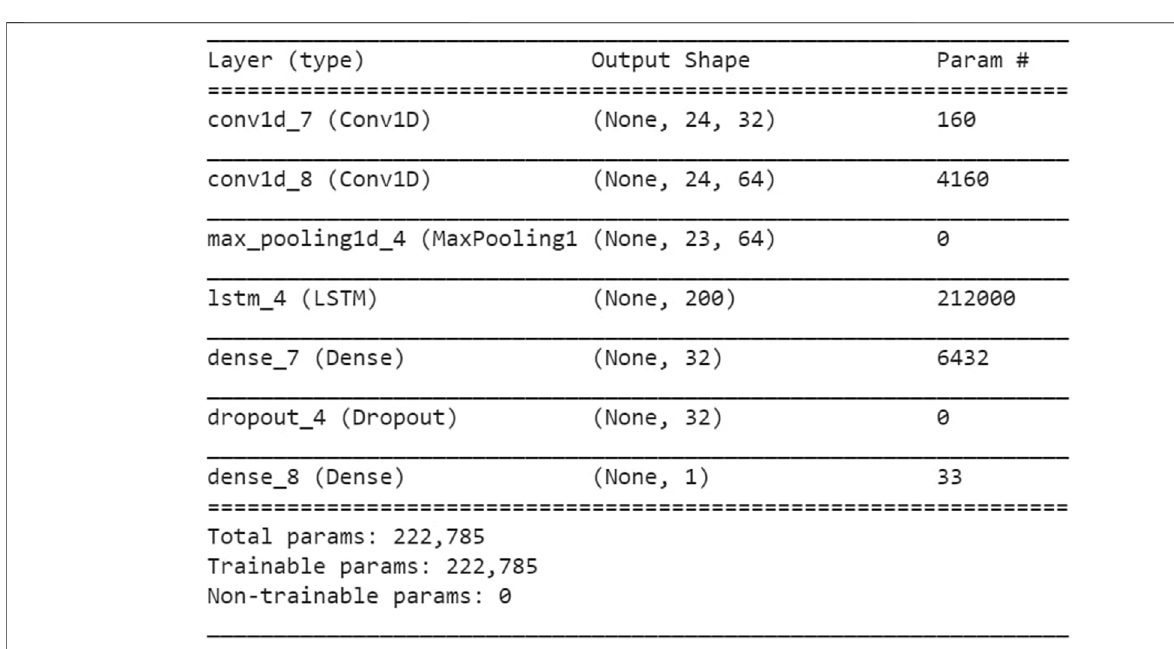
Figure 10 . The result of this model is as MAE:0,123, MSE: 00054, and RMSE:0233. The graph of actual vs predicted is as Figure 11 .